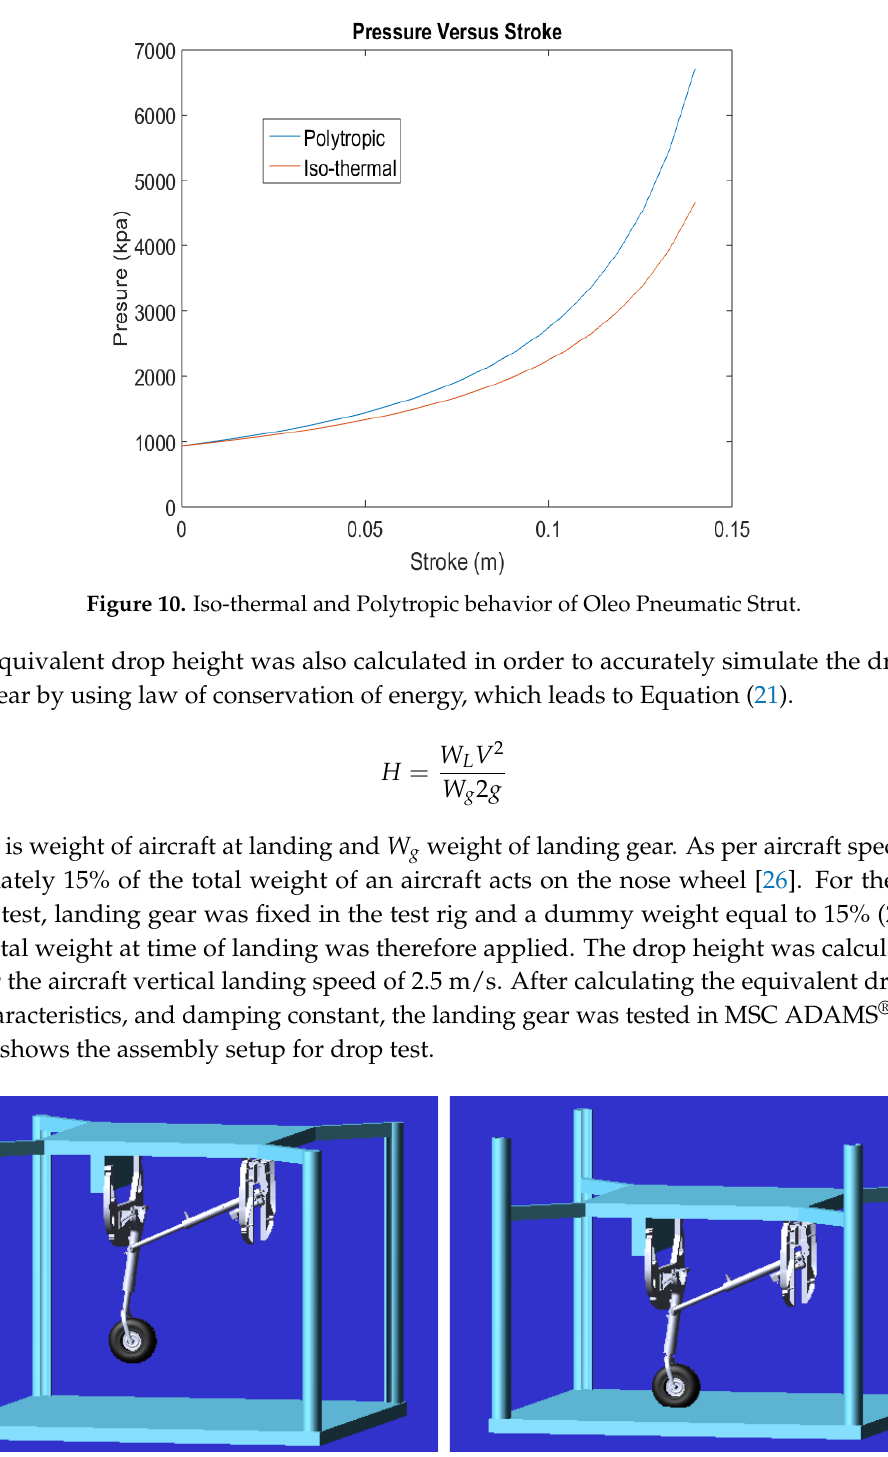
Figure 11. Drop test setup design, modelling, &